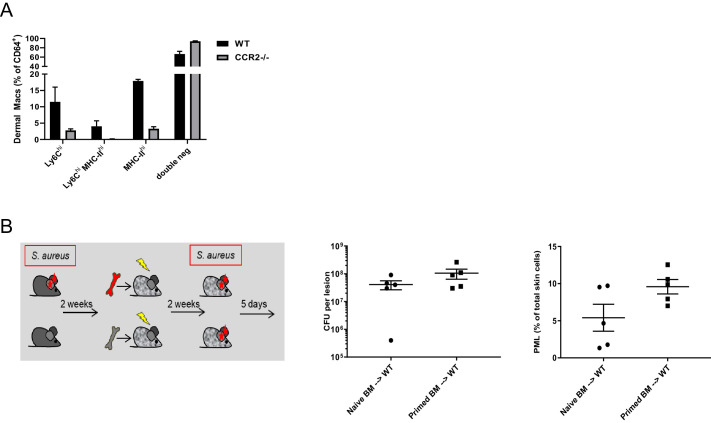
Bone marrow cells do not contribute to innate memory.(A) Comparison of dermal Mφ numbers gated as in (Figure 1—figure supplement 1B) in wt and Ccr2-/- mice in steady state. (B) CD45.1 mice mice were i.d. injected with S. aureus (107 CFU in 10 µl PBS) or PBS. After 2 weeks, bone marrow from these CD45.1 mice mice was transferred into lethally irradiated naïve wt recipient mice and after additional 2 weeks recipient mice were infected with S. aureus (107 CFU in 10 µl PBS) for 5 days (n: five biological replicates).